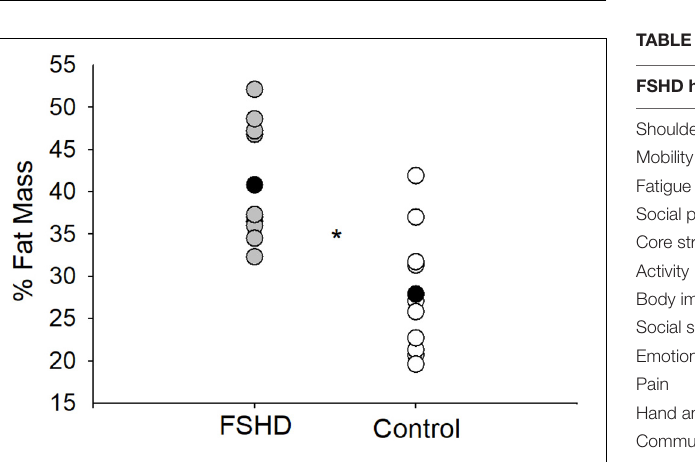
FIGURE 2 | % fat mass in FSHD and controls. Individuals with FSHD had a higher % fat mass, as compared to controls. Black circles indicate average data for each group. * p < 0.01.